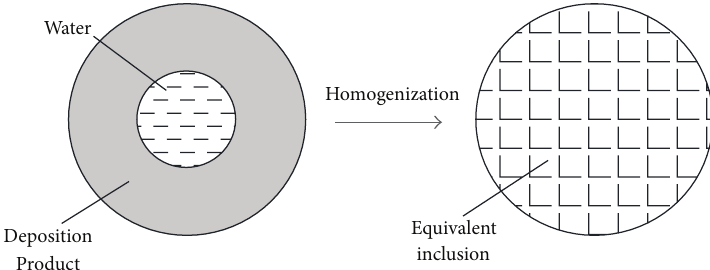
Figure 2: The equivalent inclusion obtained by the first-level micromechanical homogenization to the two-phase composite composed of the deposition products and water.